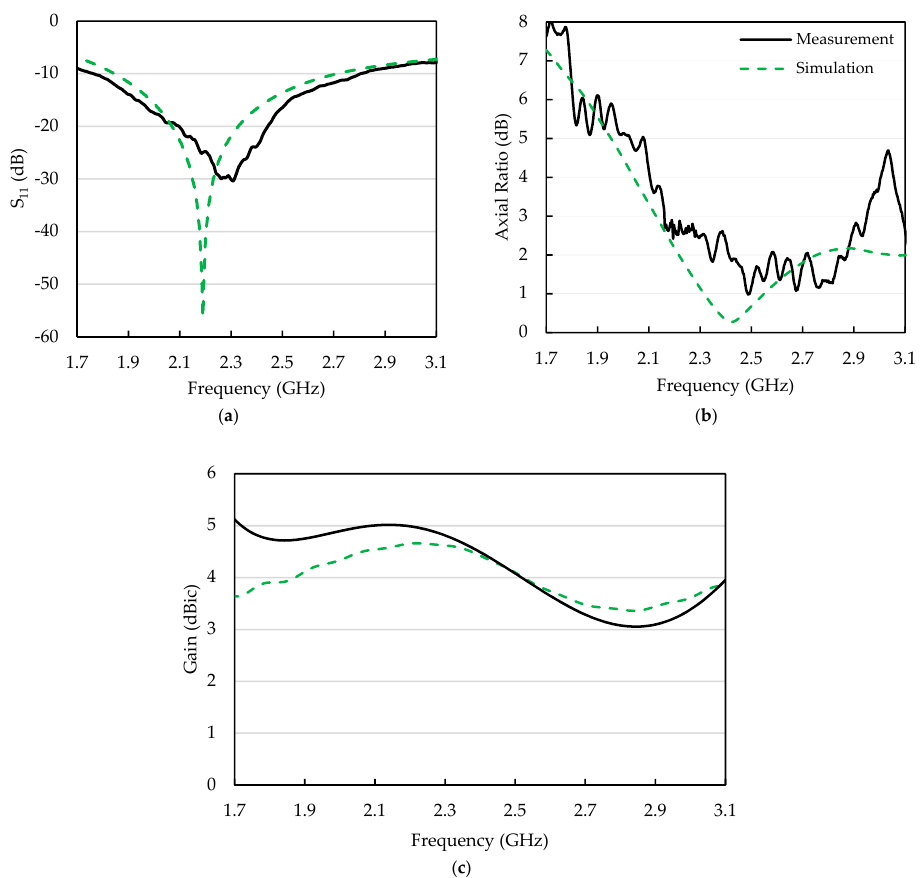
Figure 9. Simulated and measured ( a ) S (cid:2869)(cid:2869) , ( b ) axial ratio, and ( c ) antenna gain.